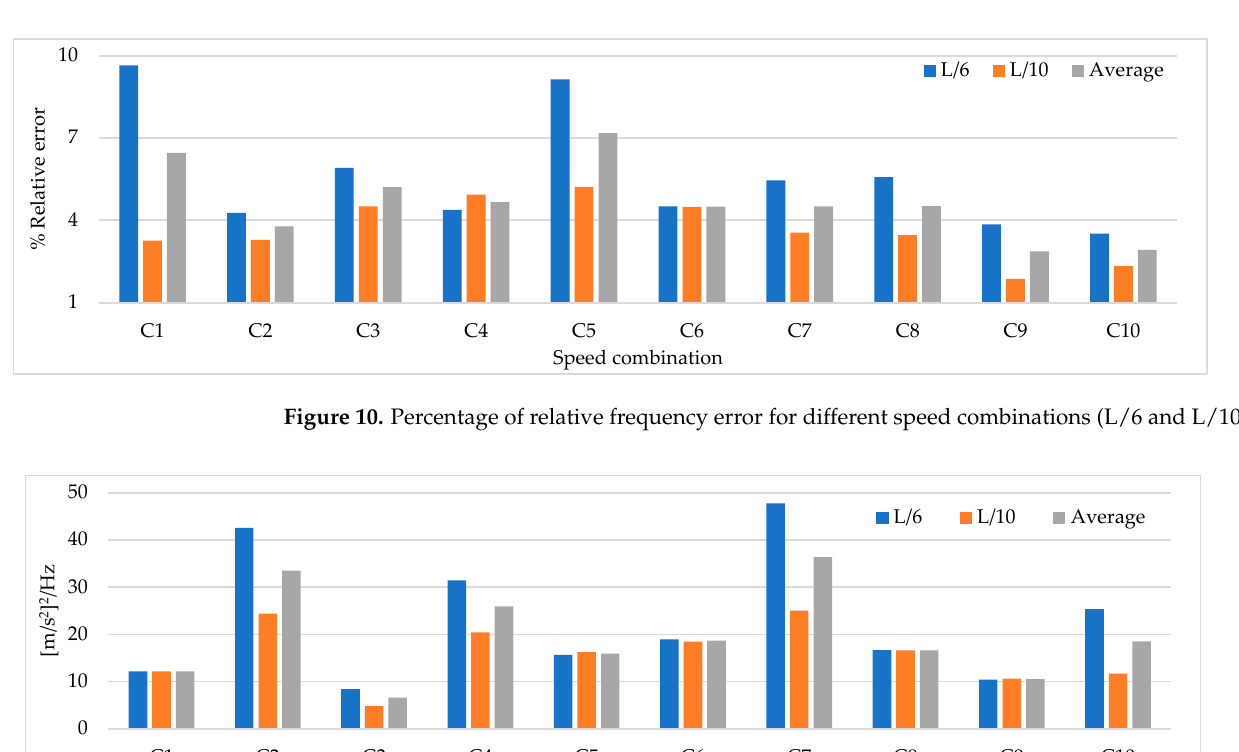
Figure 11. Magnitude of the power spectrum for different speed combinations (L/6 and L/10) (Units: [m/s 2 ] 2 /Hz).